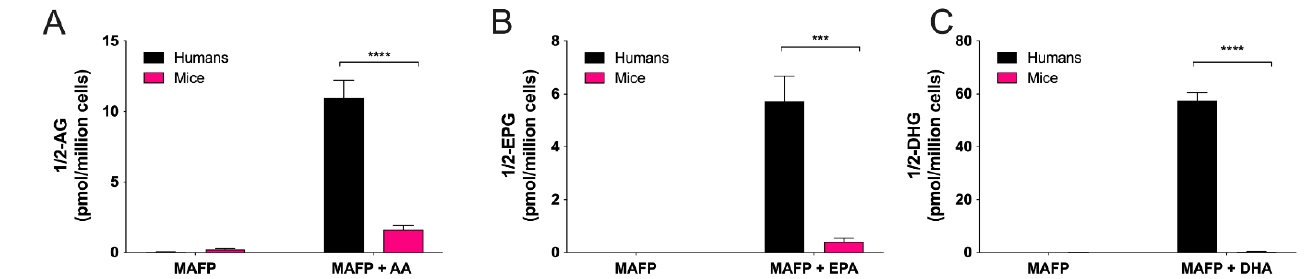
Figure 4. Biosynthesis of the endocannabinoid 2-AG and its congeners by human and mouse eosinophils. EOS suspensions (5 × 10 6 cells/mL, 37 ◦ C) were treated 1 µ M of MAFP for 5 min then incubated with DMSO or 10 µ M of ( A ) AA, ( B ) EPA, or ( C ) DHA for 15 min. Incubations were stopped by adding one volume of cold ( − 20 ◦ C) MeOH containing the internal standards. Samples were then processed and analyzed for 2-AG and related mediators by LC-MS/MS as described in Materials and Methods. Results are the mean ( ± SEM) of 4 independent experiments using human eosinophils from asthmatic donors and 5 independent experiments using bone marrow-derived mouse eosinophils. p -values were obtained as described in Materials and Methods. *** p < 0.001, **** p < 0.0001.